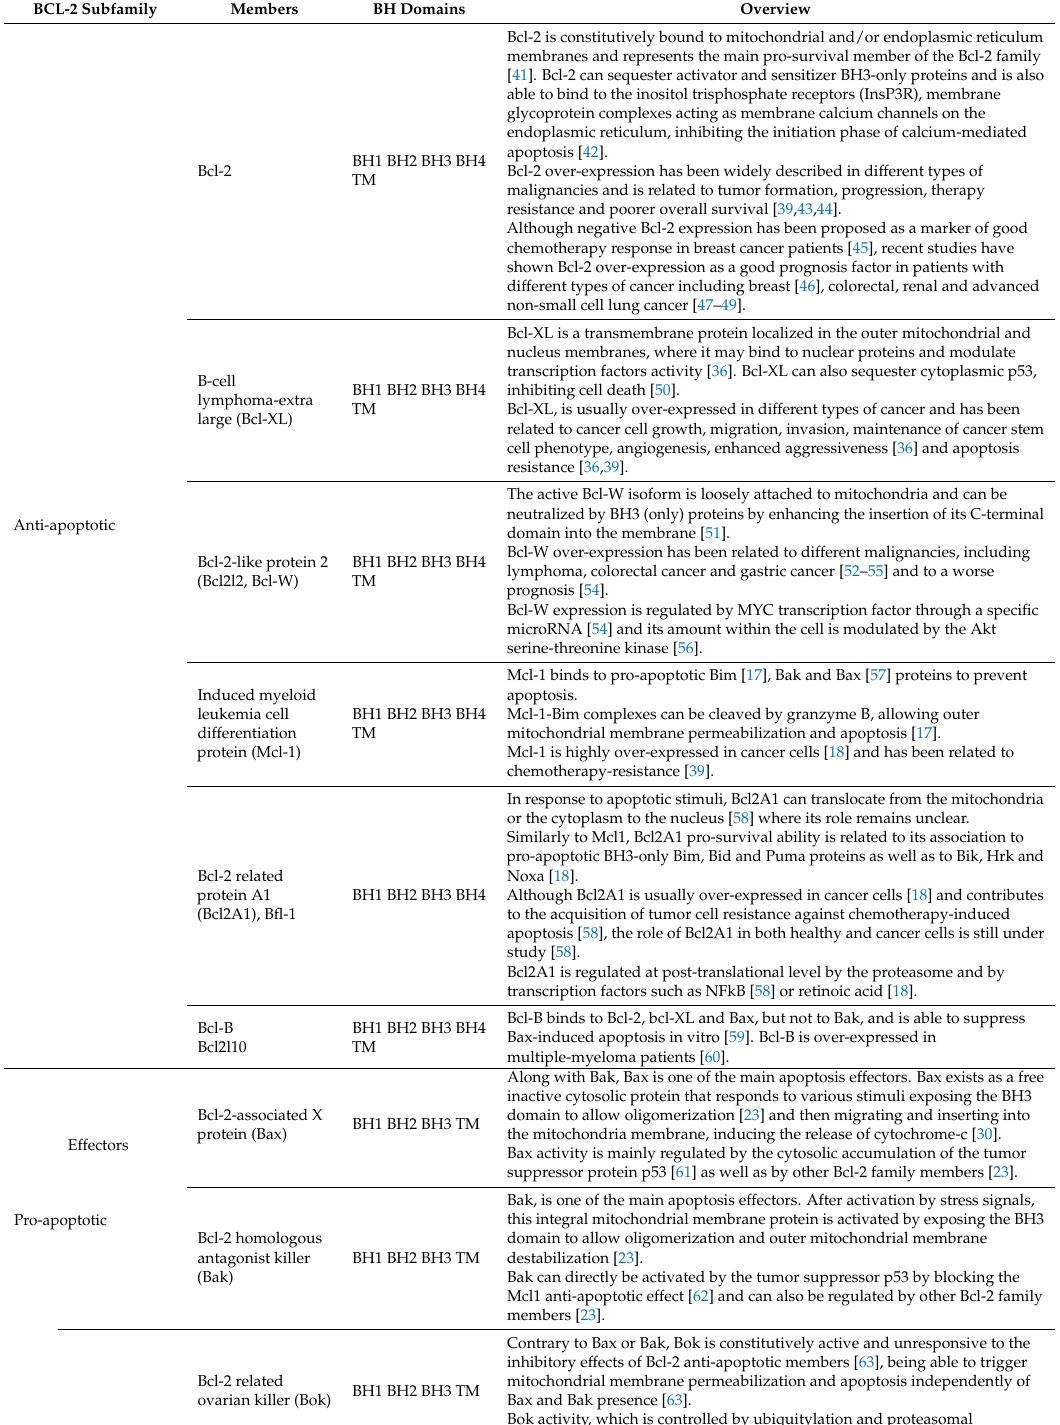
Table 5. Members of the BCL-2 protein